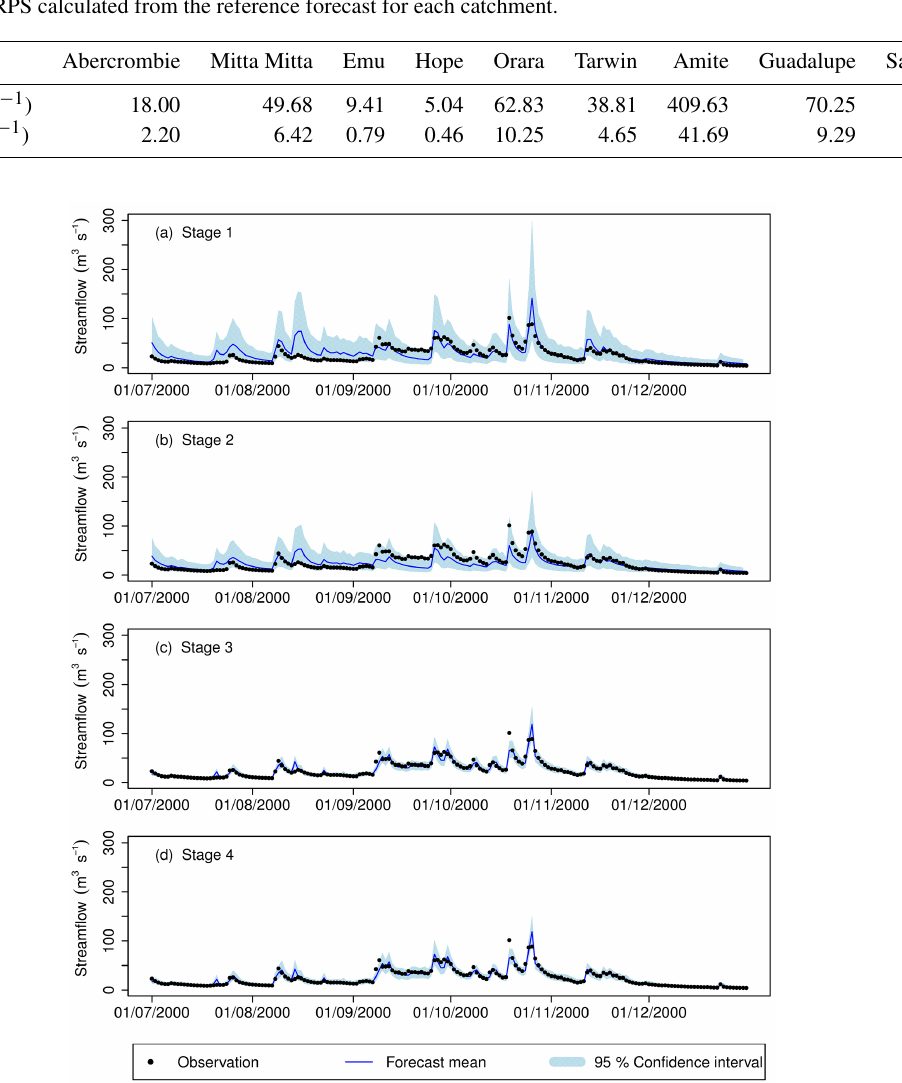
Figure 2. An example of streamflow time-series plots for the Mitta Mitta catchment in the period between 1 July 2000 and 31 December